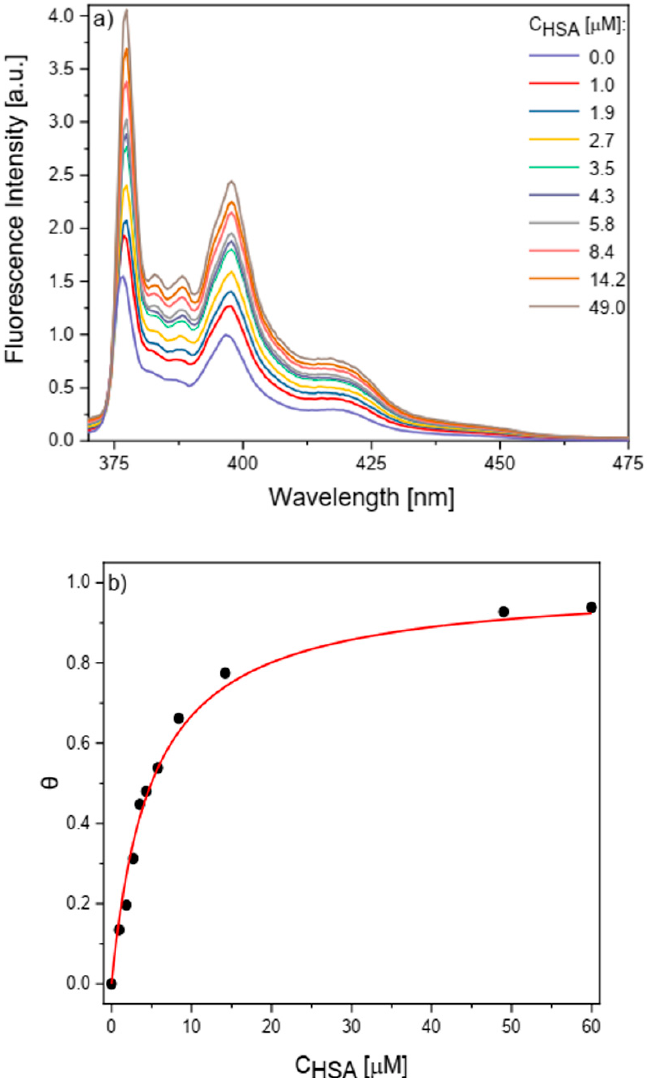
Figure 6. ( a ) fluorescence spectra of Py-LYQLENY (3 µM) with HSA in buffer solution; ( b ) dependence of parameter θ on HSA concentration.